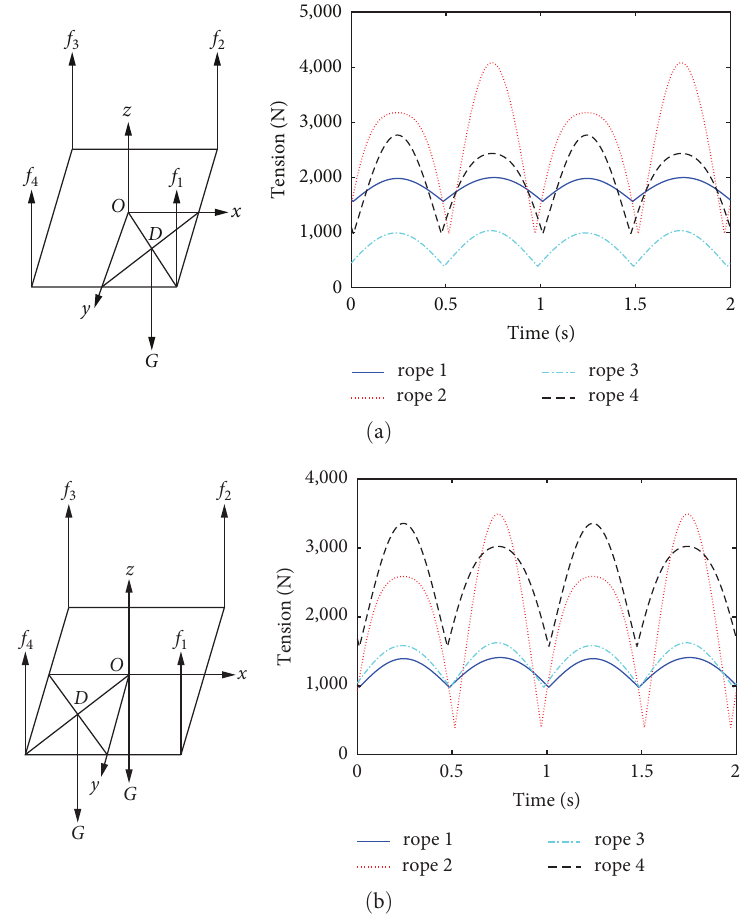
F IGURE 11: Cable force of hanging basket for uneven